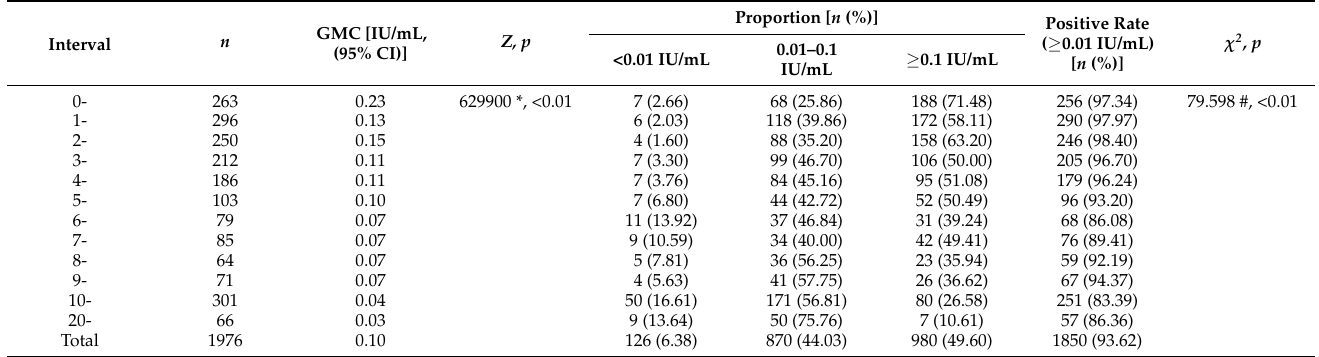
Table 6. Seroprevalence and tetanus antibody level since the last dose of tetanus-toxoid-containing vaccines